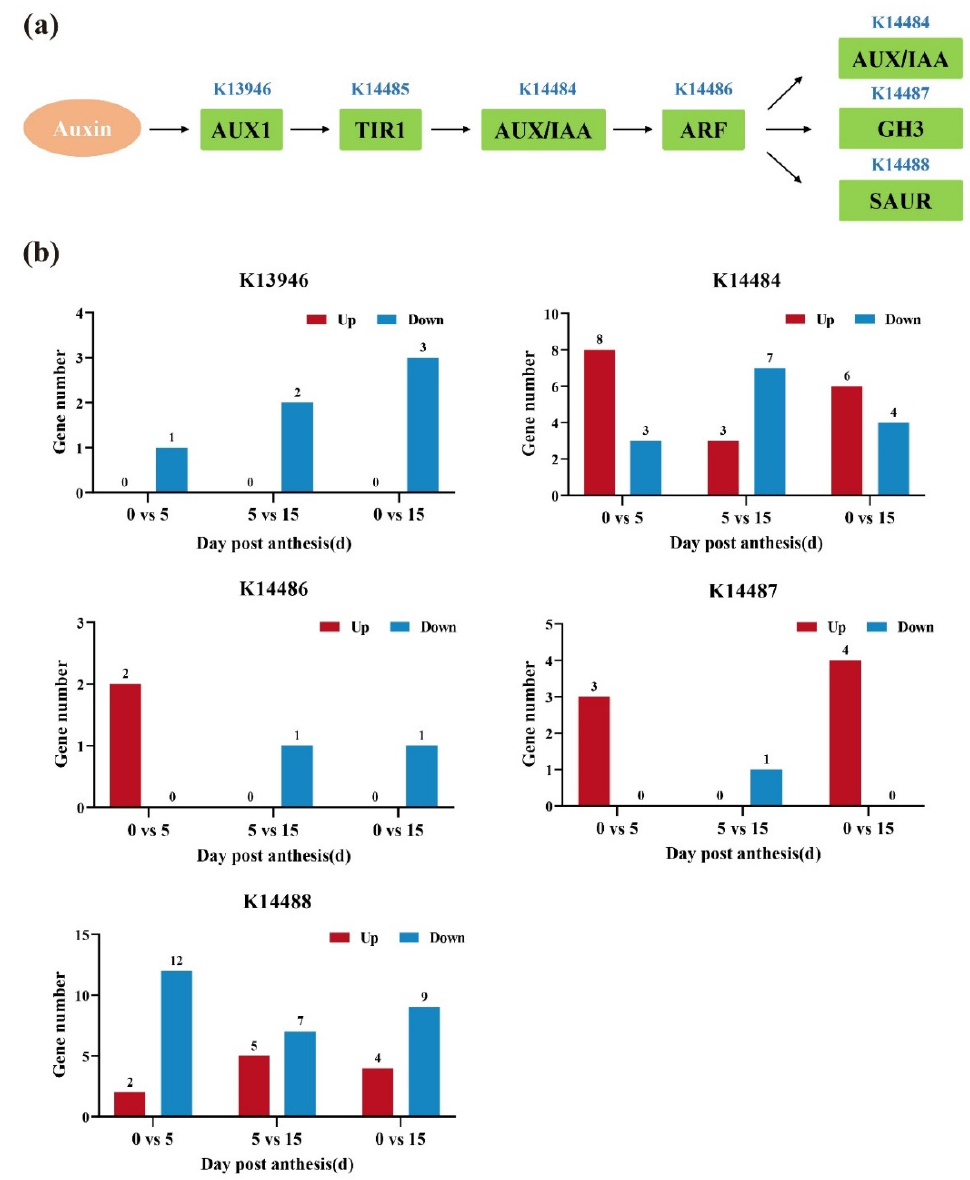
Figure 5. The transcript abundance of DEGs involved in the auxin signaling pathway in the three considered stages. ( a ) The auxin signaling pathway in tomatoes. ( b ) Numbers of DEGs involved in the auxin signaling pathway in all three stages.